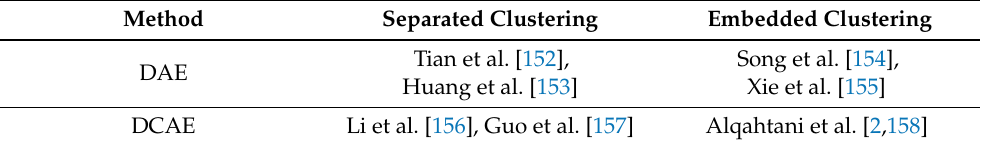
Table 1. Deep Clustering Methods. Separated clustering consists of two main steps, where they extract latent features for given data and then perform clustering on the learned representations. Embedded clustering methods have embedded a clustering algorithm into deep neural networks, where feature representations and clustering assignments are simultaneously learned, applying a joint loss function. Method Separated Clustering Embedded Clustering Tian et al. [152], Song et al. [154], DAE Huang et al. [153] Xie et al. [155] DCAE Li et al. [156], Guo et al. [157] Alqahtani et al.